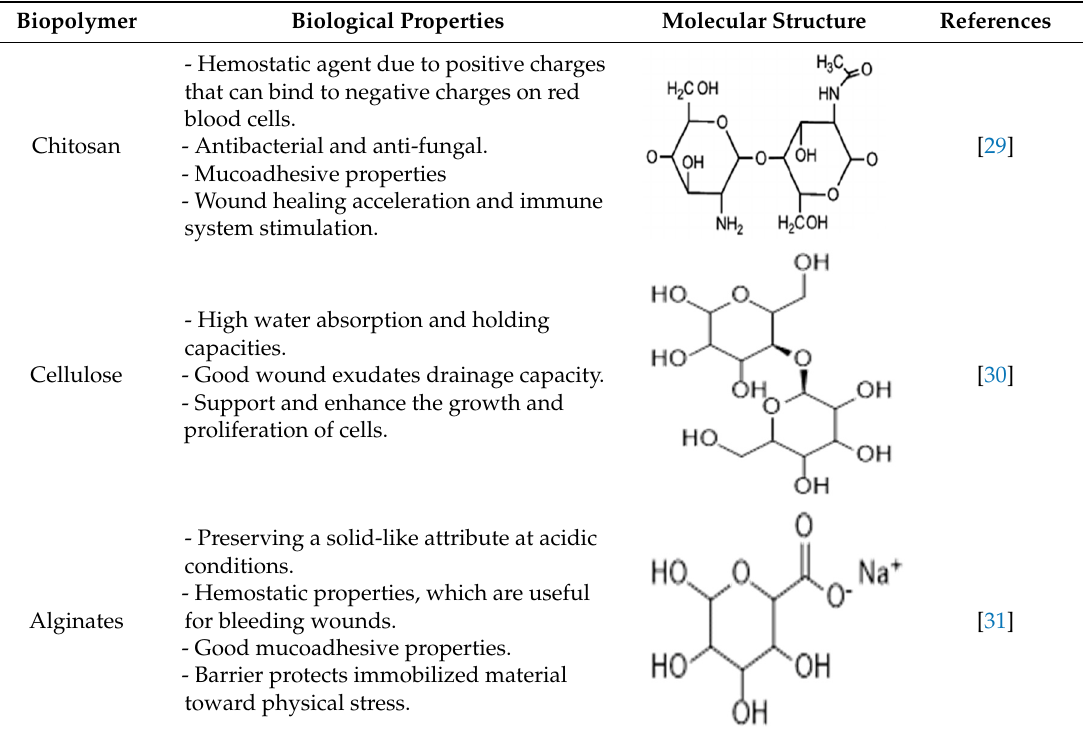
Table 1. Biological, wound healing properties and molecular structures of chitosan, cellulose and alginate.